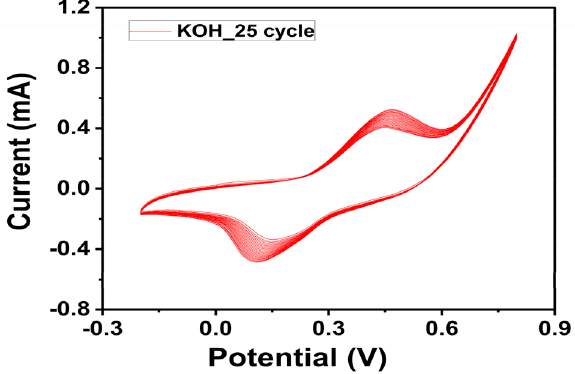
Figure 6. Consecutive cyclic voltammogram of Ni 11 Pt 3 Cr 6% /CNFs (C3) in 1 M KOH solution at 100 mV/s SR.